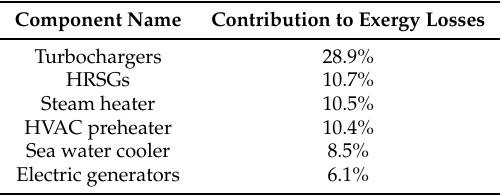
Table 2. Major contributors to ship exergy losses. Losses related to combustion are not included in the